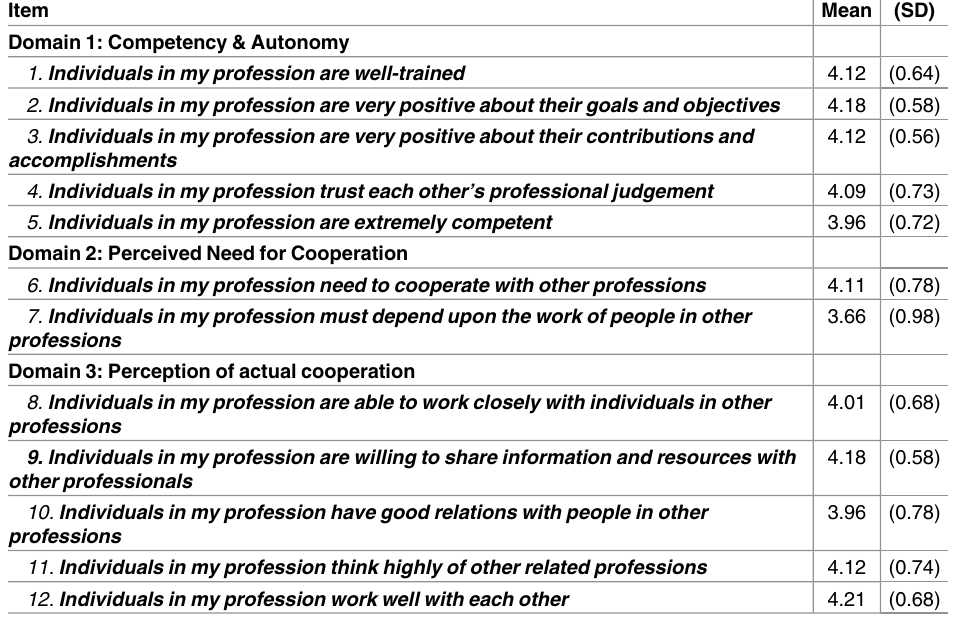
Table 3. Mean scores of each item of IEPS (n = 809).